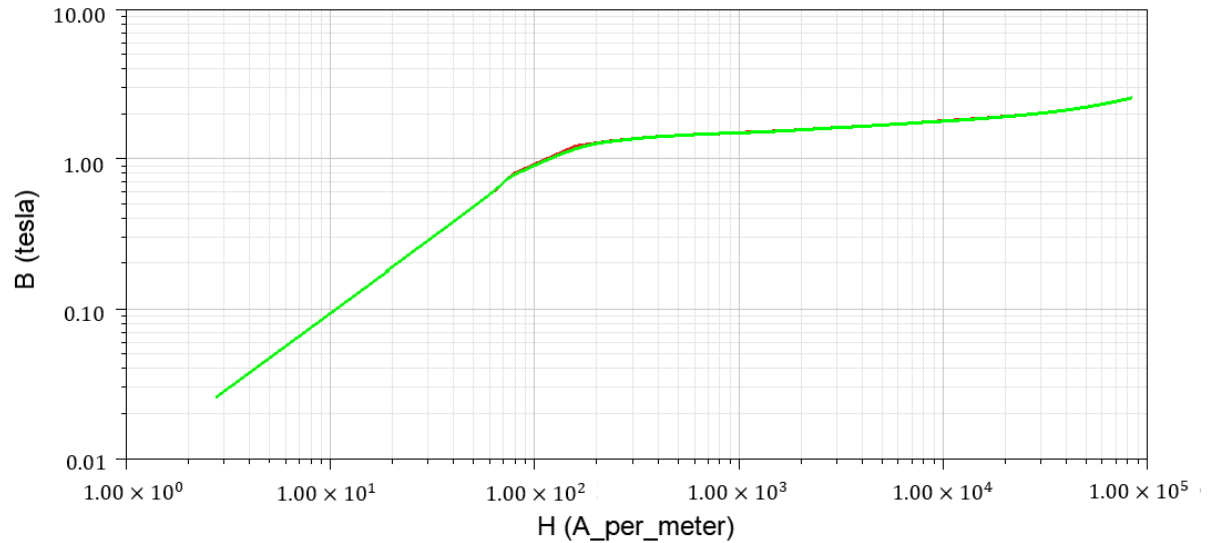
Figure 2. The magnetic nonlinearity of SXRE750. The stator winding is double-layer. The 3-D electromagnetic FEM model of the hydro- generator and its mesh are shown in Figure 3 and Figure 4,